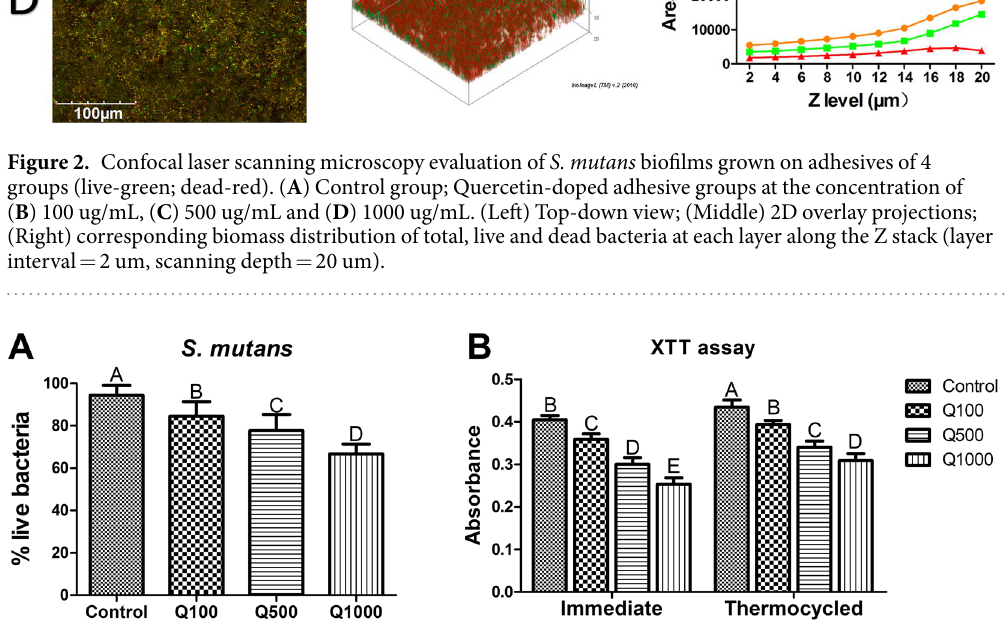
Figure 3. ( A ) Percentage distributions of live bacteria among total biomass based on the CLSM calculation result, n = 10. ( B ) The average XTT OD 570 values after 24 h incubation of S. mutans on adhesives of 8 groups (4 for immediate groups, and 4 for thermocycling aged groups), n = 9. The data are expressed as the mean ± SD, groups with the same superscripts are not statistically significant ( P >